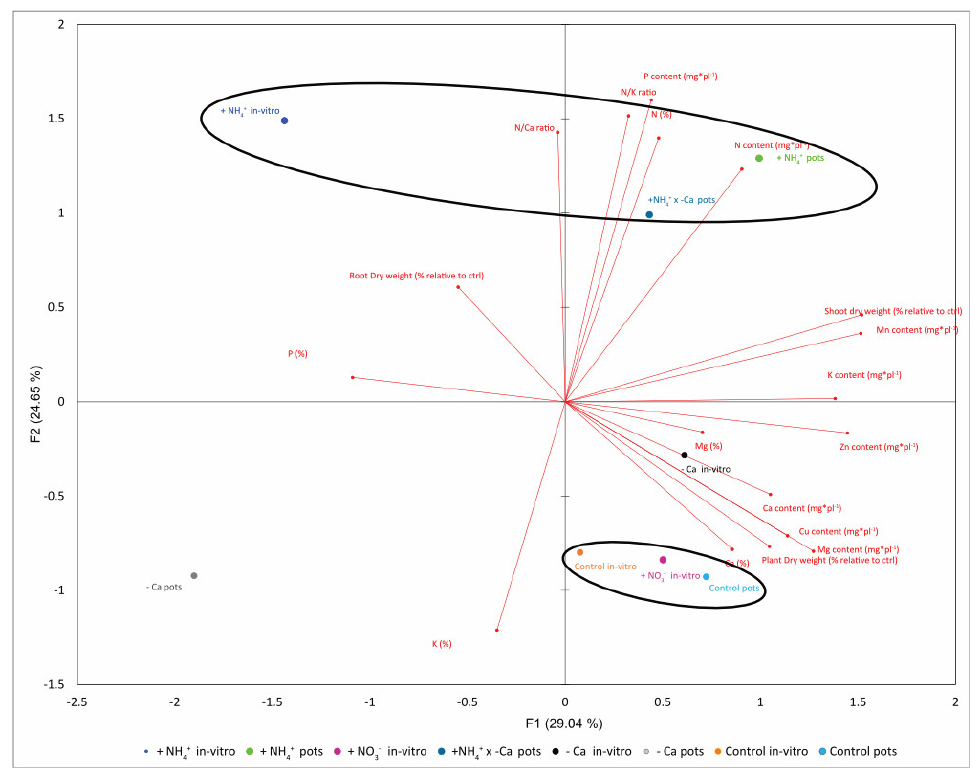
Figure 6. Principal component analysis of physiological and nutritional parameters reveals a relationship of ammonium excess and N/Ca ratio. tionship of ammonium excess and N/Ca